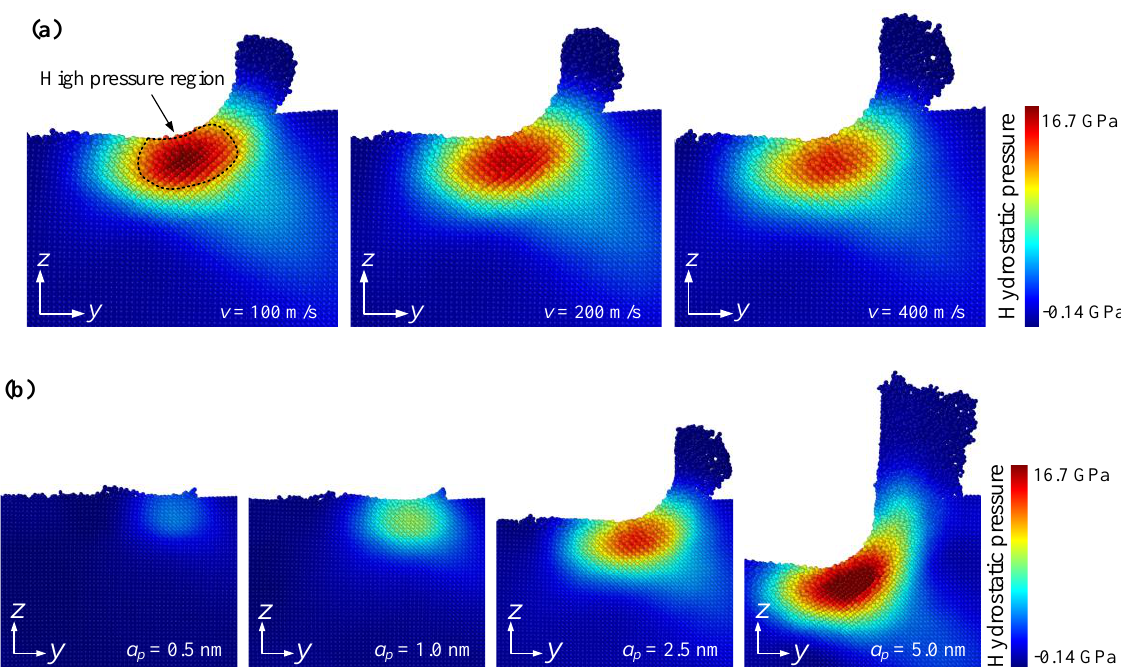
Figure 9. The effects of ( a ) cutting speed and ( b ) undeformed cutting thickness on the hydrostatic pressure during nanometric cutting.